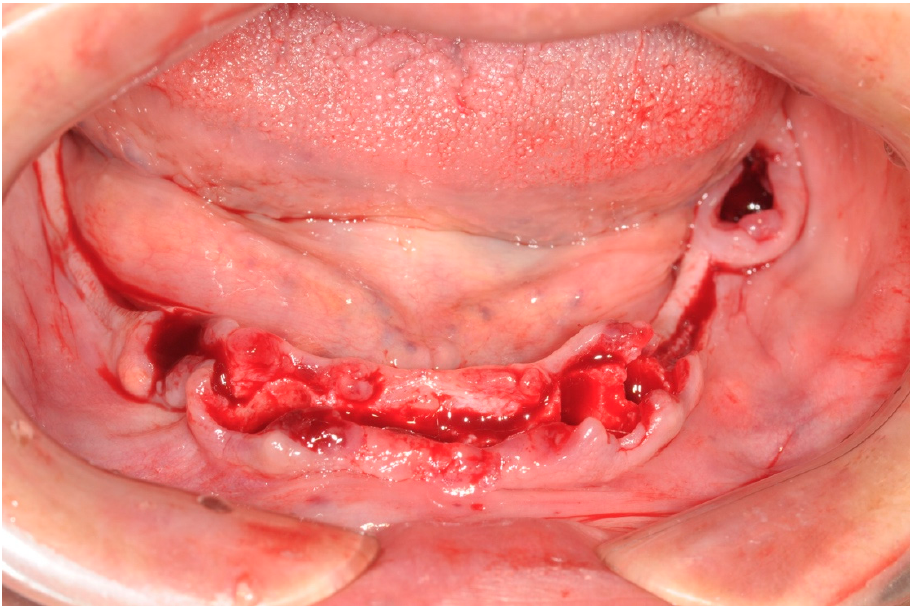
Figure 2. Operative site after tooth extractions.